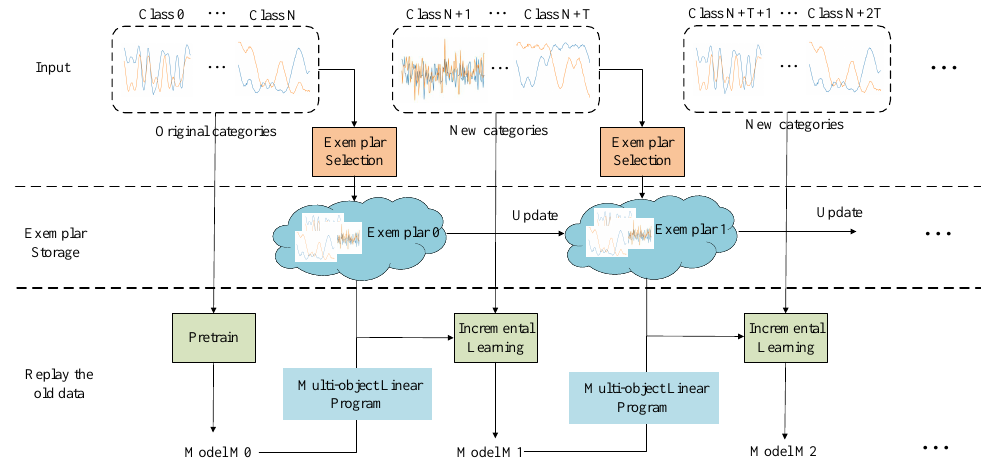
Figure 1. Overview of the proposed framework,